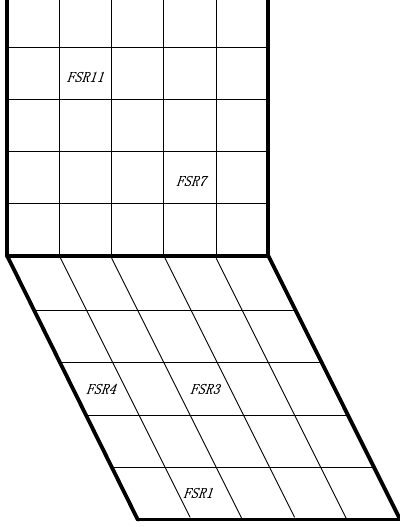
Figure 5. Selected sensors of the best configuration. Table 8. Backward selection of the best sensor configuration. Bold font highlights the best accuracy for each number of active